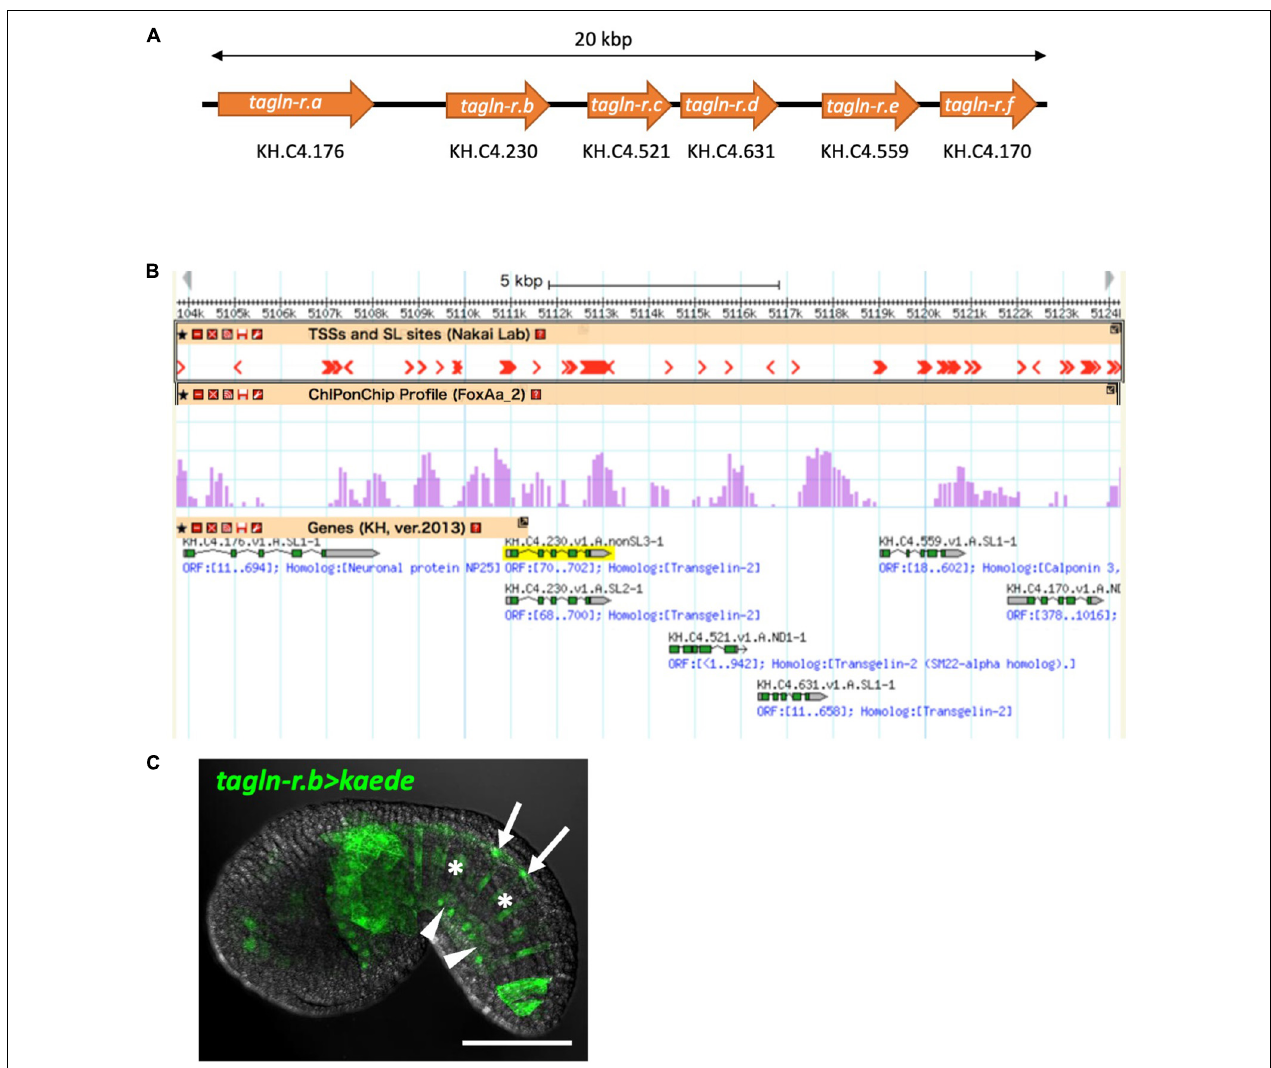
FIGURE 3 | The calponin/transgelin family gene cluster in the Ciona genome. (A) Schematic diagram of the gene cluster. Six genes, tagln-r.a , tagln-r.b , tagln-r.c , tagln-r.d , tagln-r.e , and tagln-r.f , each encoding a calponin/transgelin family protein are clustered in a 20-kb genomic region. (B) The transcriptional landscape of the tagln-r loci. Transcription start sites (TSSs) and spliced leader (SL) trans -splicing sites (Yokomori et al., 2016) and FoxA.a binding sites determined by ChIP-on-chip analysis (Kubo et al., 2010) were mapped on the Ghost Genome Browser (Satou et al., 2005, 2008). (C) Localization of Kaede reporter expressed under the control of the upstream cis -regulatory region of tagln-r.b . Arrows , arrowheads , and asterisks indicate the floor plate, the endodermal strand, and the notochord, respectively. Scale bar, 50 µ